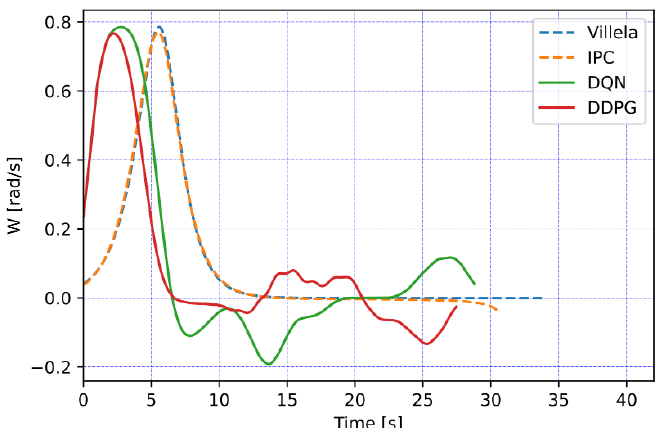
Figure 11. Angular velocity of the experiment without obstacles.